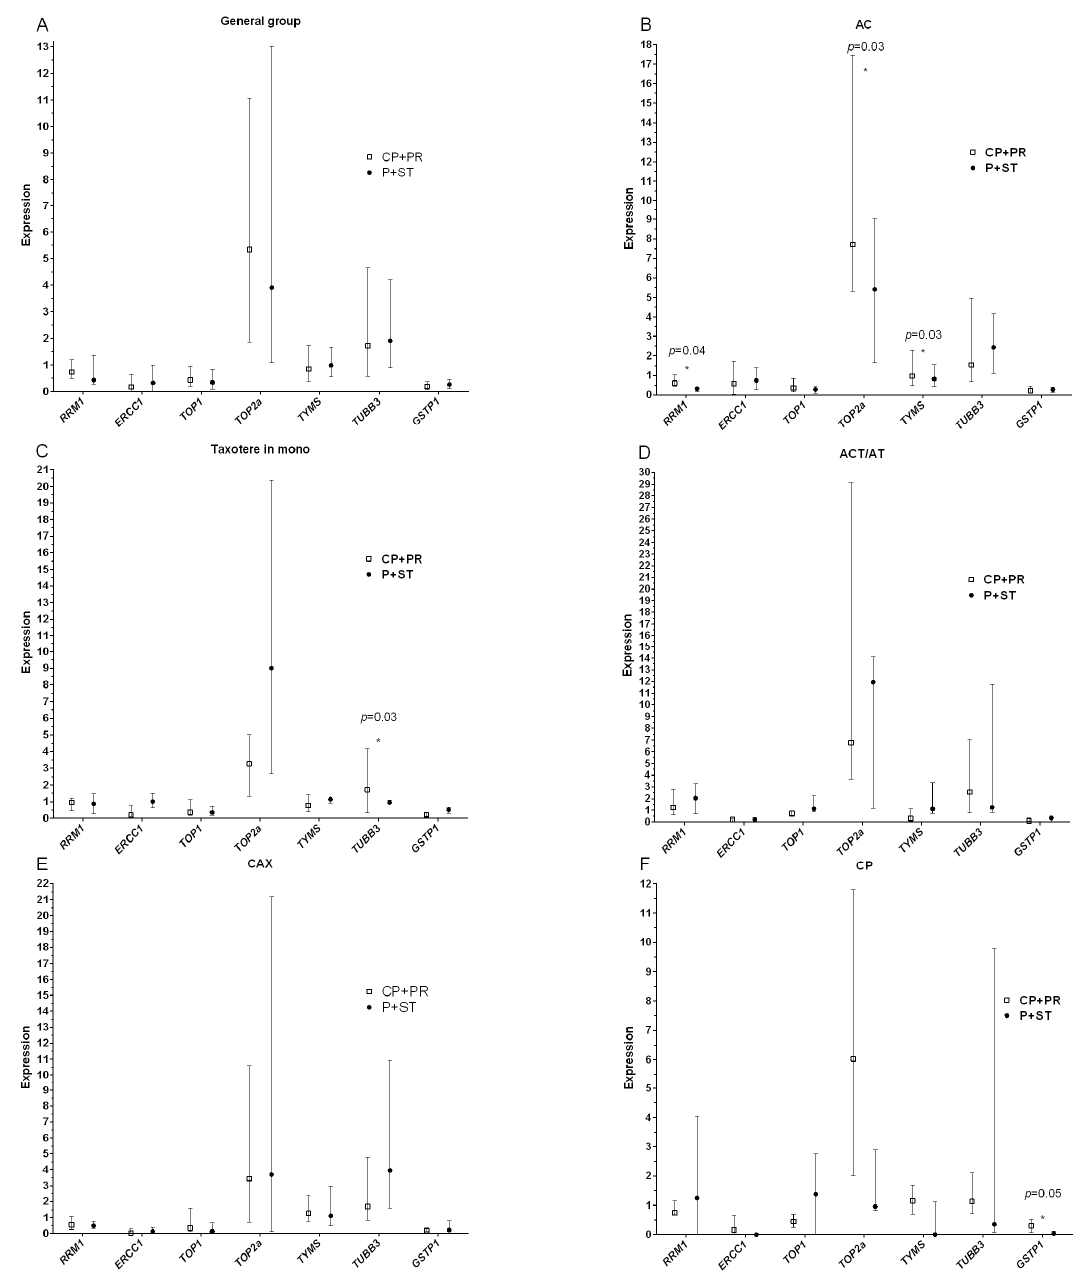
Figure 1. Diagrams of the relationship between the initial level of mRNA expression and the NAC effect in the general group of patients ( A ), depending on the chemotherapy scheme: ( B )—scheme AC, ( C )—scheme Taxotere in mono-regimen, ( D )—scheme AT/ACT, ( E )—scheme CAX, ( F )—scheme CP. Note: CR + PR—complete and partial regression; P + ST—progression and stabilization; *—statistically significant result. The figure shows the medians of expression and the interquartile range of 25–75% for each gene in patient groups depending on the effect of NAC.